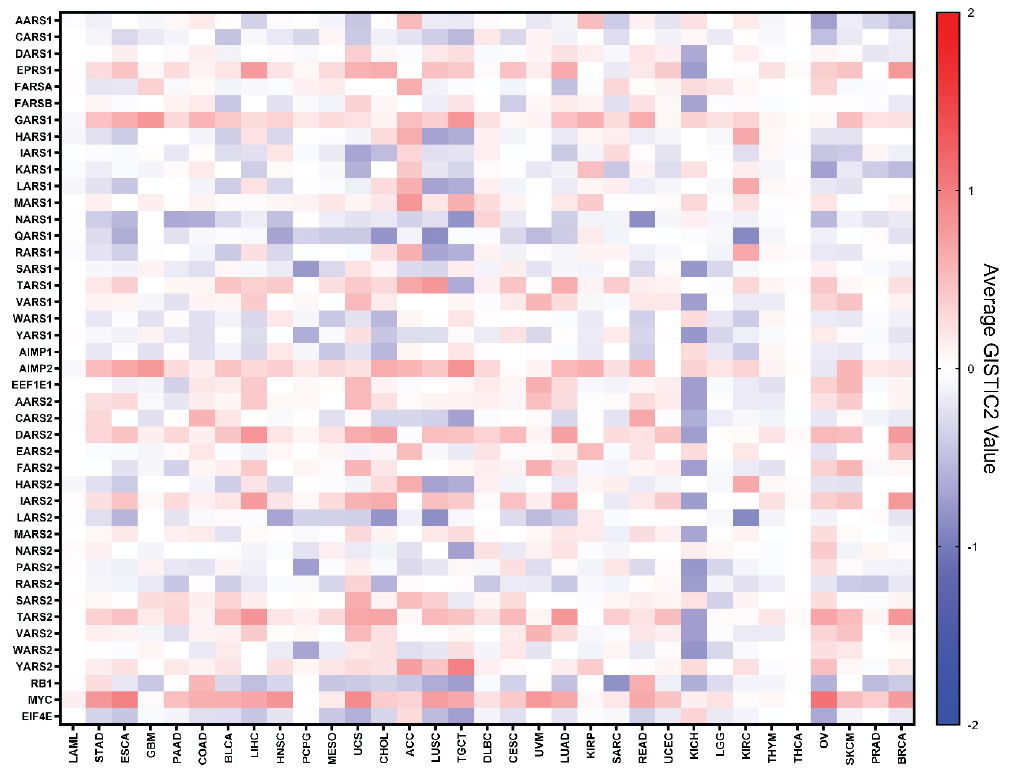
Figure 2. Average GISTIC2 values for aaRSs over each TCGA cancer type. The average GISTIC2 values, representing the degree of amplification or deletion, are represented for each gene. The values correspond to the degree of modification from − 2.0 (blue) representing deep deletion to + 2.0 (red) representing high-level amplification. The 33 cancer types are sorted based on overall survival data from the TCGA database, from shortest median time to event (death) (acute myeloid leukemia, LAML) to the longest (breast invasive carcinoma,